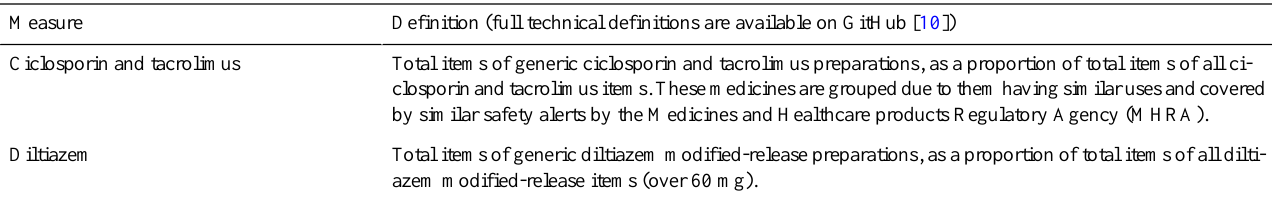
Table 1. OpenPrescribing measures of generic ciclosporin, tacrolimus, and diltiazem